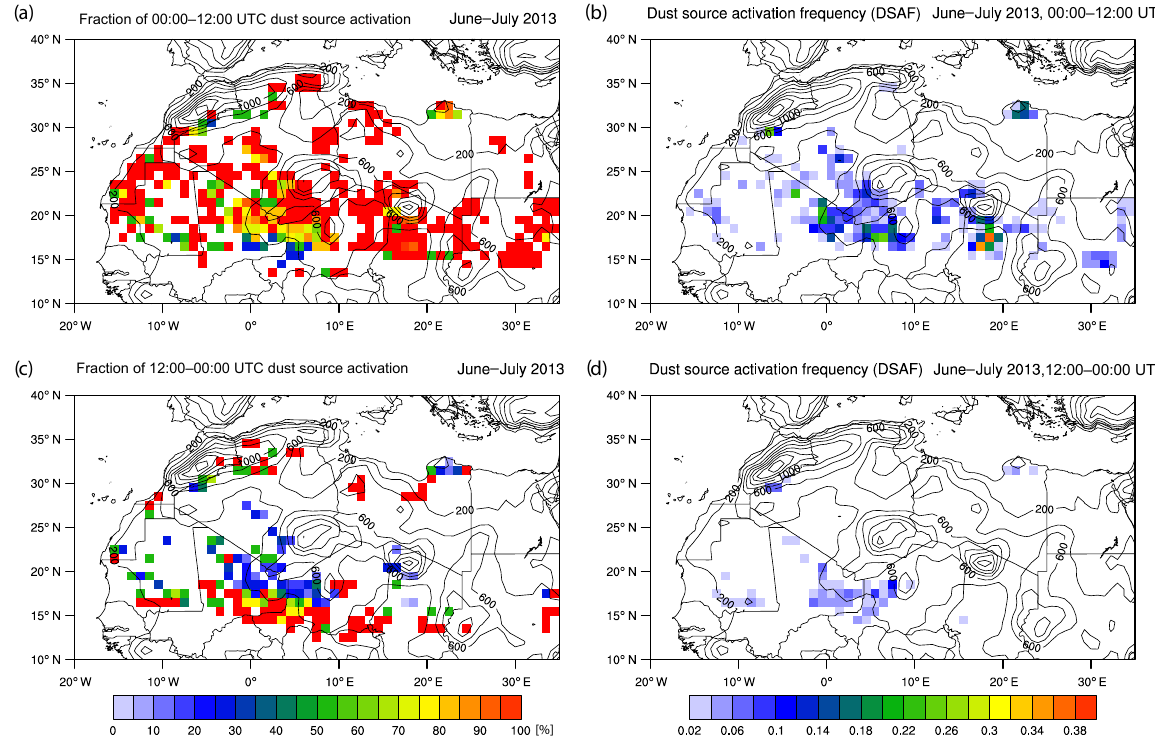
Figure 2. Occurrence frequency of dust source activation (fraction of days with dust occurrence) for the 2-month period June and July 2013 for the first half of the day (a, b) and the second half of the day (c, d) expressed by fraction of the total (a, c) and occurrence frequency (b, d)